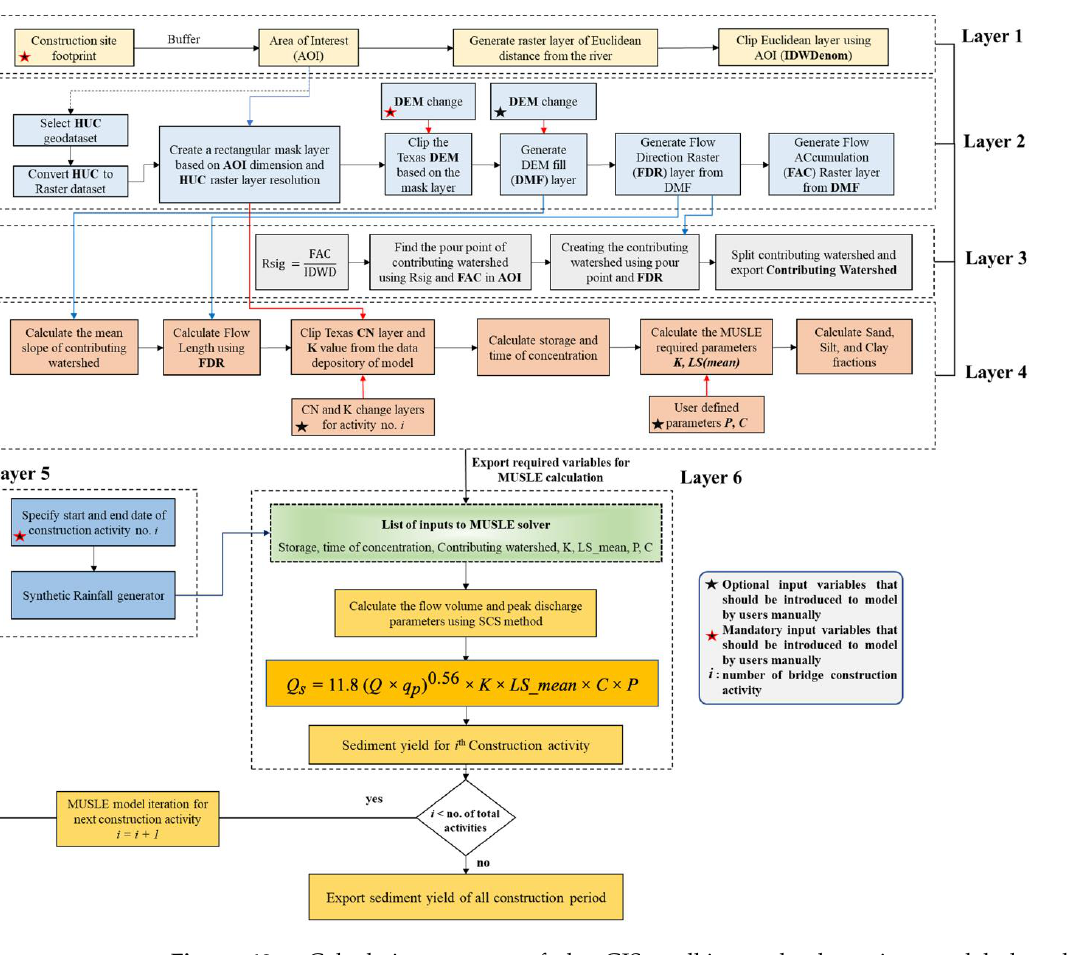
Figure 12. Calculation process of the GIS toolkit overland erosion model, based on the MUSLE